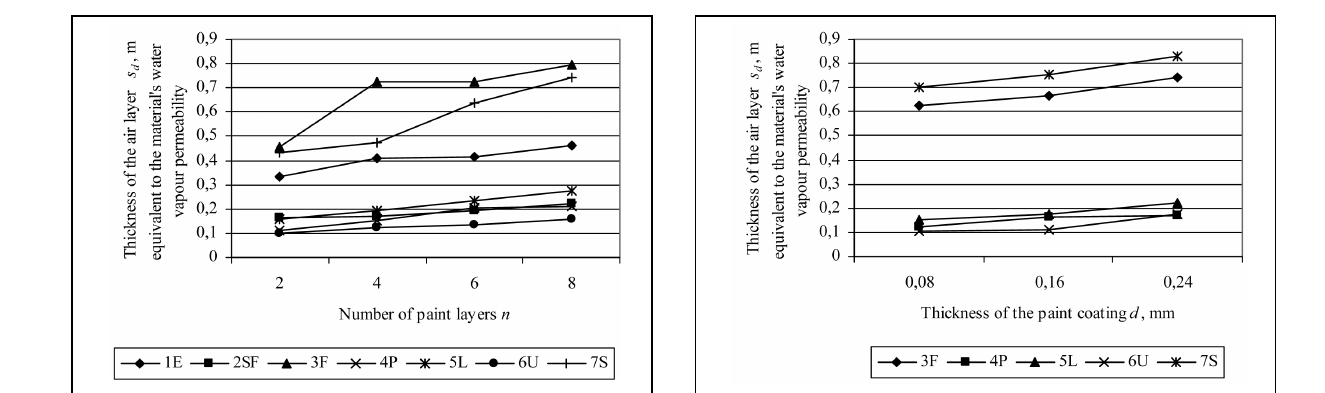
equivalent to the d